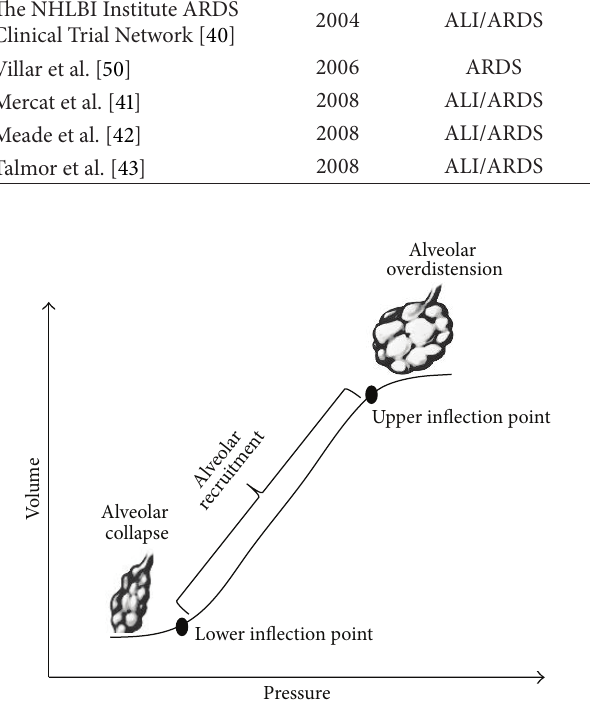
Figure 2: Pressure-volume curve with lower and upper inflection points. According to PEEP level, the recruitment of collapsed alveoli could be set between the lower and the upper inflection